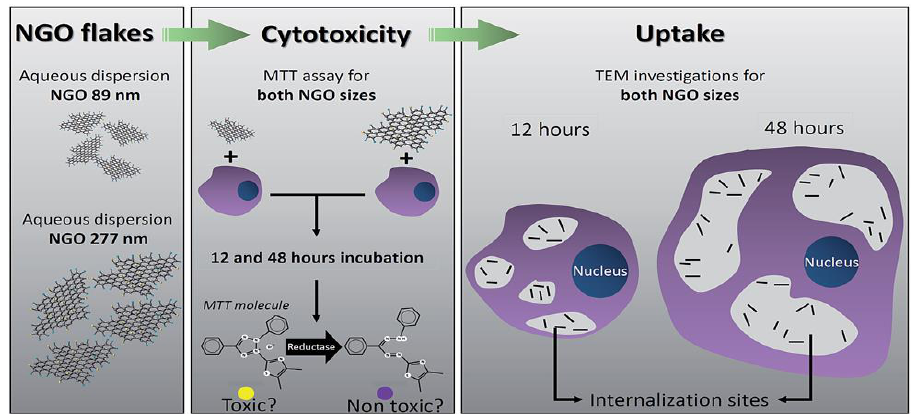
Figure 10. Schematic showing the strategies used to assess size-dependent cytotoxicity and internalization of nanographene oxide (NGO). Reproduced from [111] with permission of the Royal Society of Chemistry.